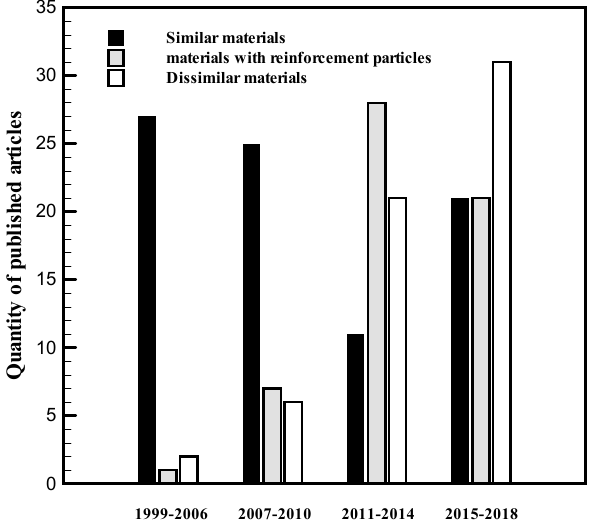
Figure 2. Trend in material selection for ARB experiments based on Google Scholar.